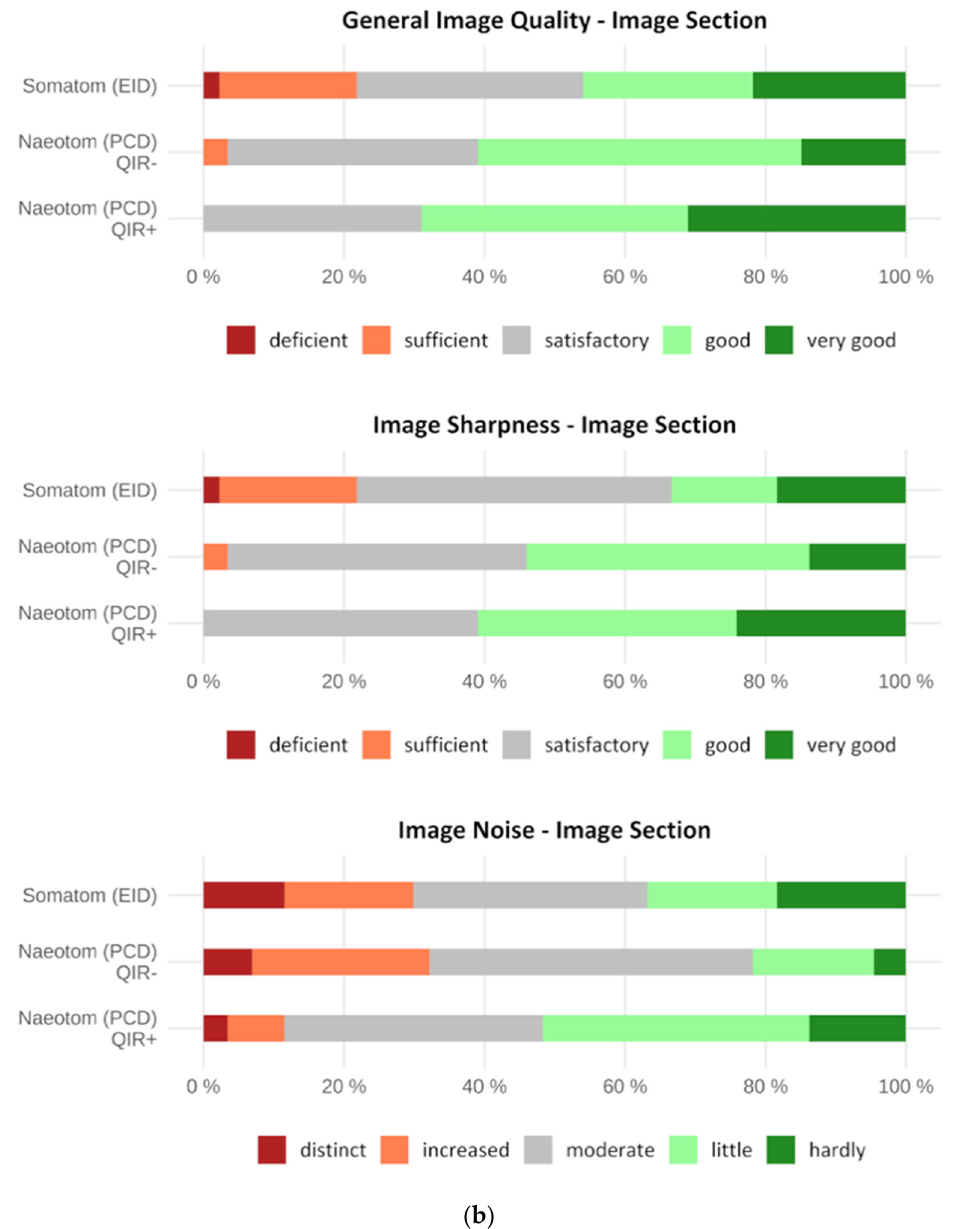
Figure 2. ( a ) Horizontal stacked bar chart showing the qualitative image evaluation of whole lung images. General image quality, image sharpness and image noise were assessed using a 5-point Likert scale. General image quality and image sharpness were rated best in PCD-CT (QIR+) images by the readers. In contrast, image noise was rated best in EID-CT images (without iterative reconstruction). ( b ) Horizontal stacked bar chart showing the qualitative image evaluation of image sections. General image quality, image sharpness and image noise were assessed using a 5-point Likert scale. General image quality, image sharpness and image noise were rated best in PCD-CT (QIR+) image sections by the readers.